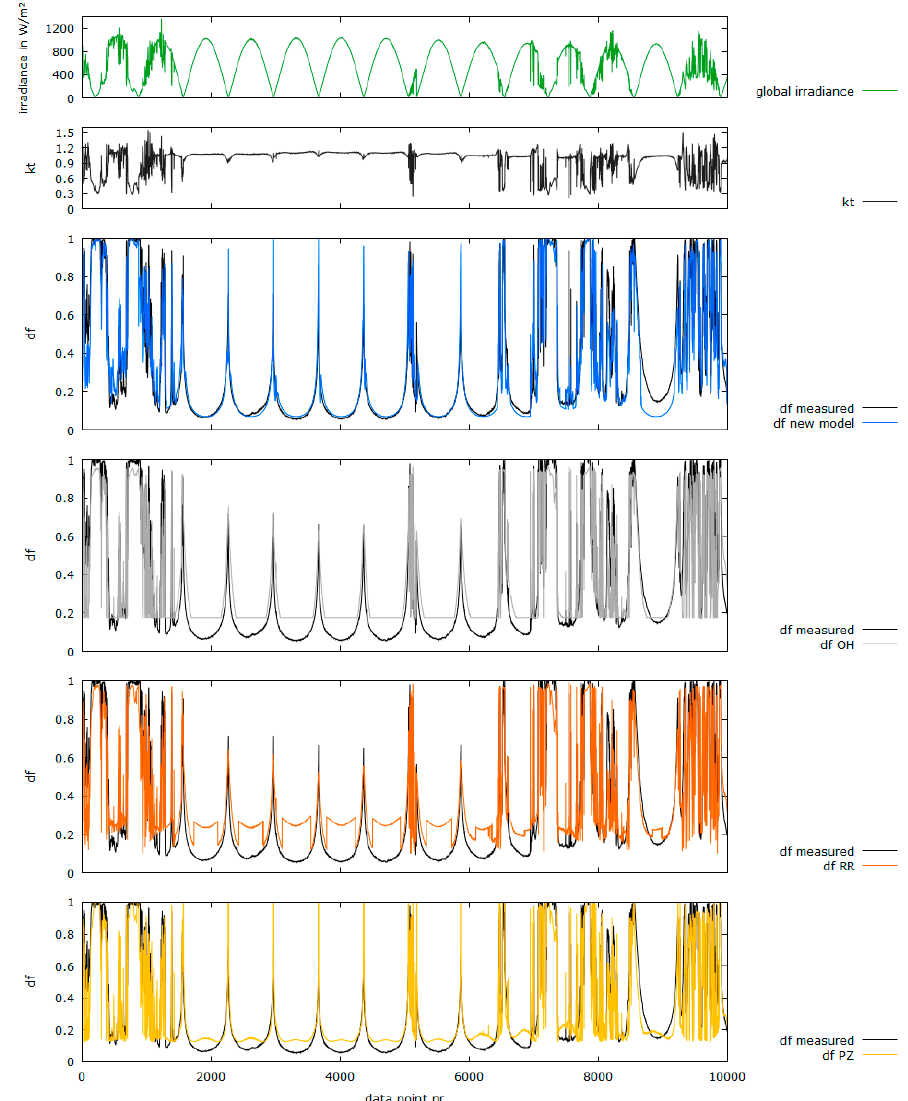
Figure 12. Plot of measured and modelled irradiance values for 14 consecutive days in Alice Springs, Australia, 2005, as an example. The total amount of analysed data sets comprises one year in minutes for each of the 28 test cases (refer to Section 2.1), equaling to seven million datapoints. Values at night are omitted in this plot. The measured global irradiance (green) is shown on top, the resulting clearness index kt (black) for reference in the middle. The bottom part of the diagram displays measured (black) and modelled diffuse fractions (blue for the new model, grey for Orgill and Hollands [18], orange for Reindl et al. [3], yellow for Perez and Ineichen [23]). Most of the time, the output of the new model leads to good conformity for clear sky days as well as for days with broken clouds. The inherent problem of static one- or two-parameter models becomes apparent when comparing the measurement values to the output of the models by Orgill and Hollands [18], Reindl et al. [3] and Perez and Ineichen [23], especially for clear sky